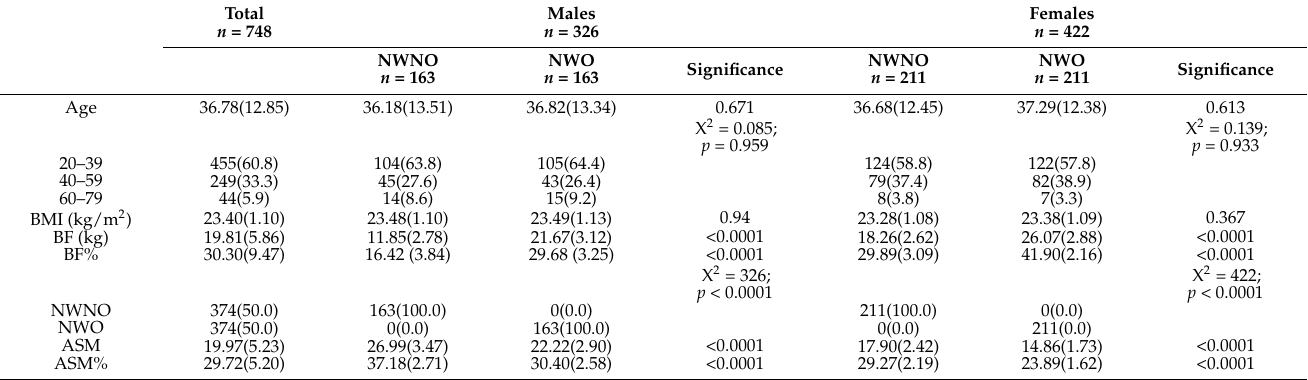
Table 1. Demographic and anthropometric characteristics of the study participants ¥ ( n = 748).